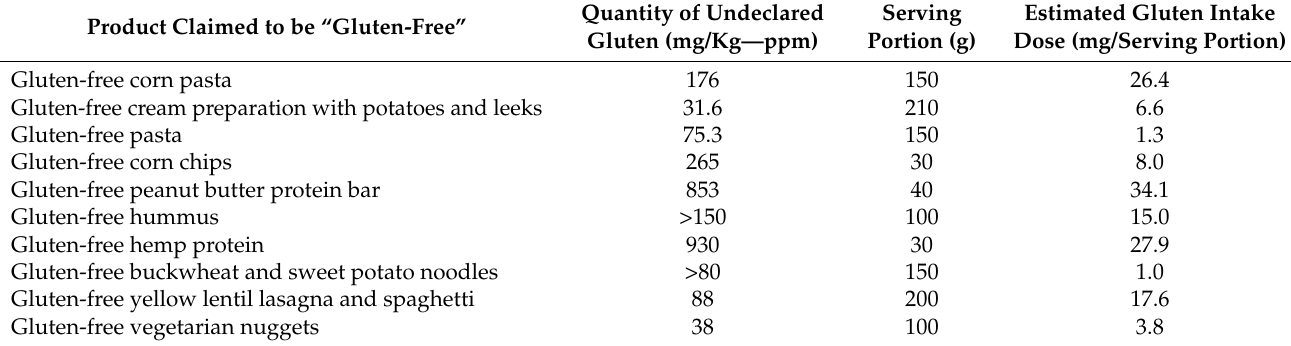
Table 4. Examples of estimated gluten-intake dose via “gluten-free” products according to their serving portions and notifications of undeclared gluten